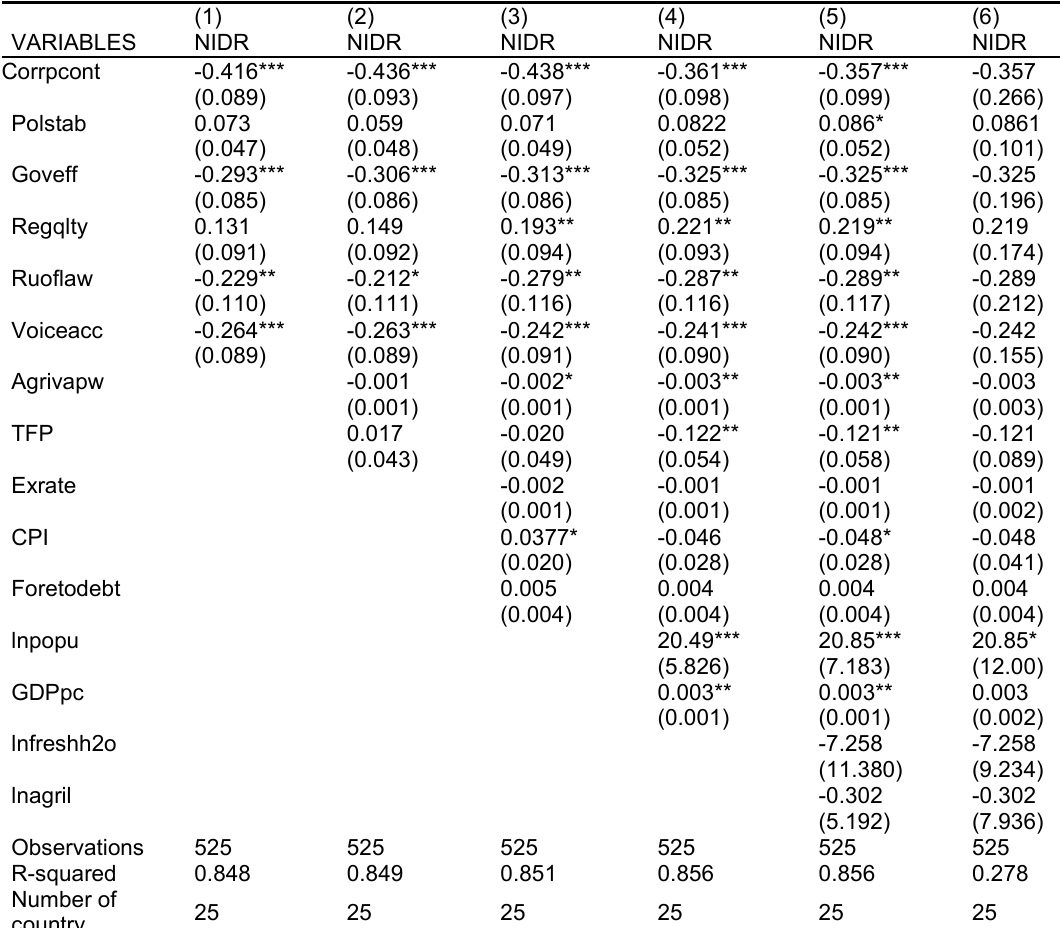
Table 3. Regression results for net-import dependency and governance